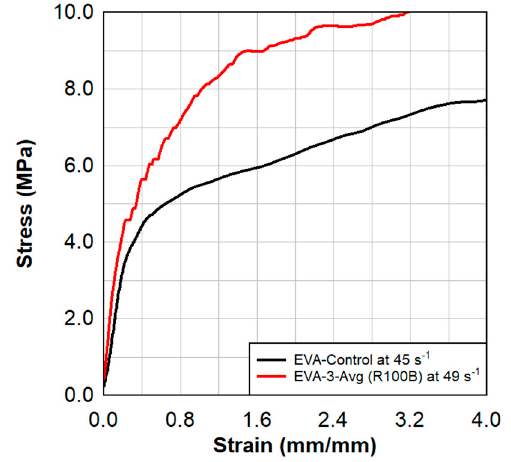
Figure 11. Dynamic tensile test results of the average of the radiated EVA − 3 specimens in comparison to the virgin EVA.